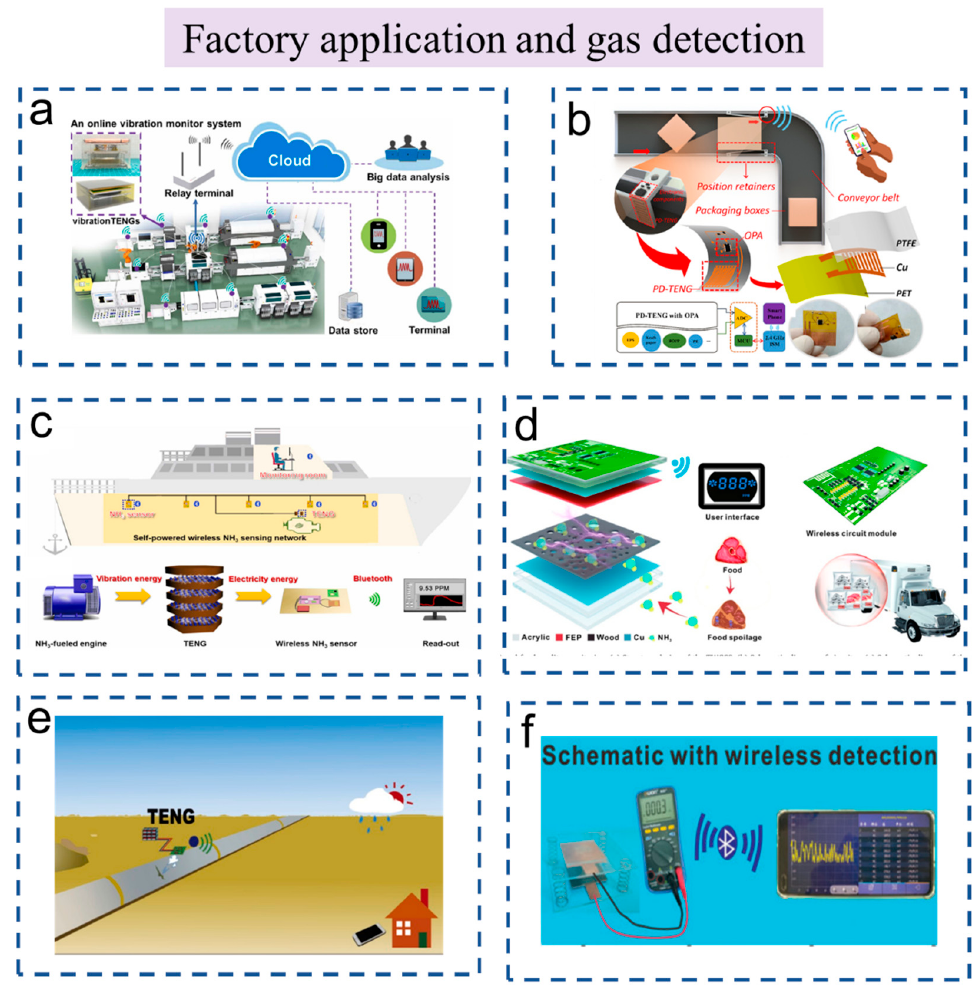
Figure 8. The self-powered wireless sensors and systems based on TENG used in industrial